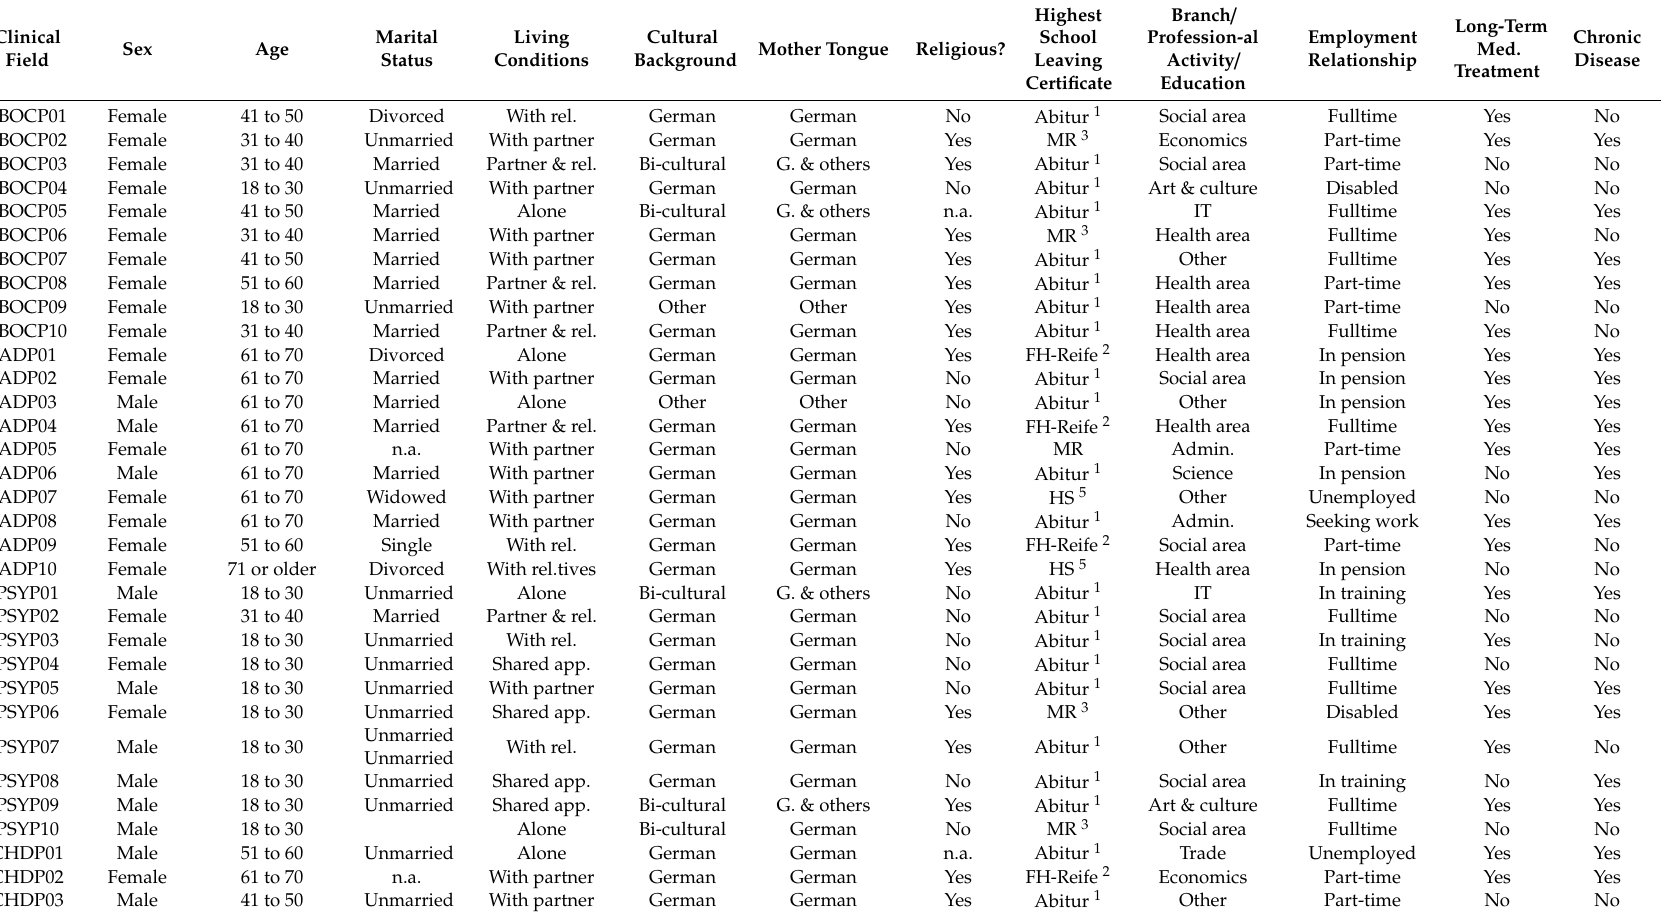
Table A4. Sociodemographic sample description per interview